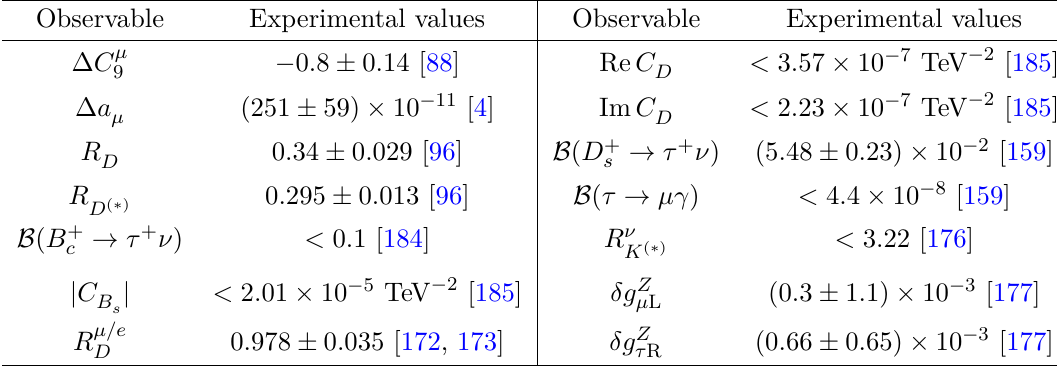
Table 2 . The best-fit values together with the 1 σ intervals, or the upper bounds corresponding to 95% C.L. of the relevant observables.